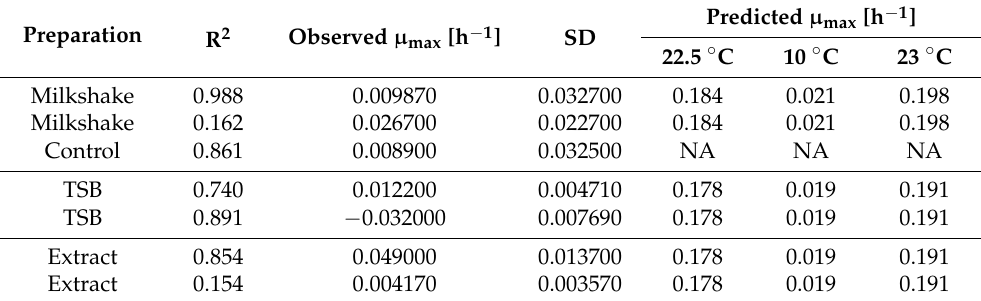
Table A5. Observed and predicted values of maximum growth rate for samples of goji berry milk- shake, extract, and TSB medium in temperature profile II.